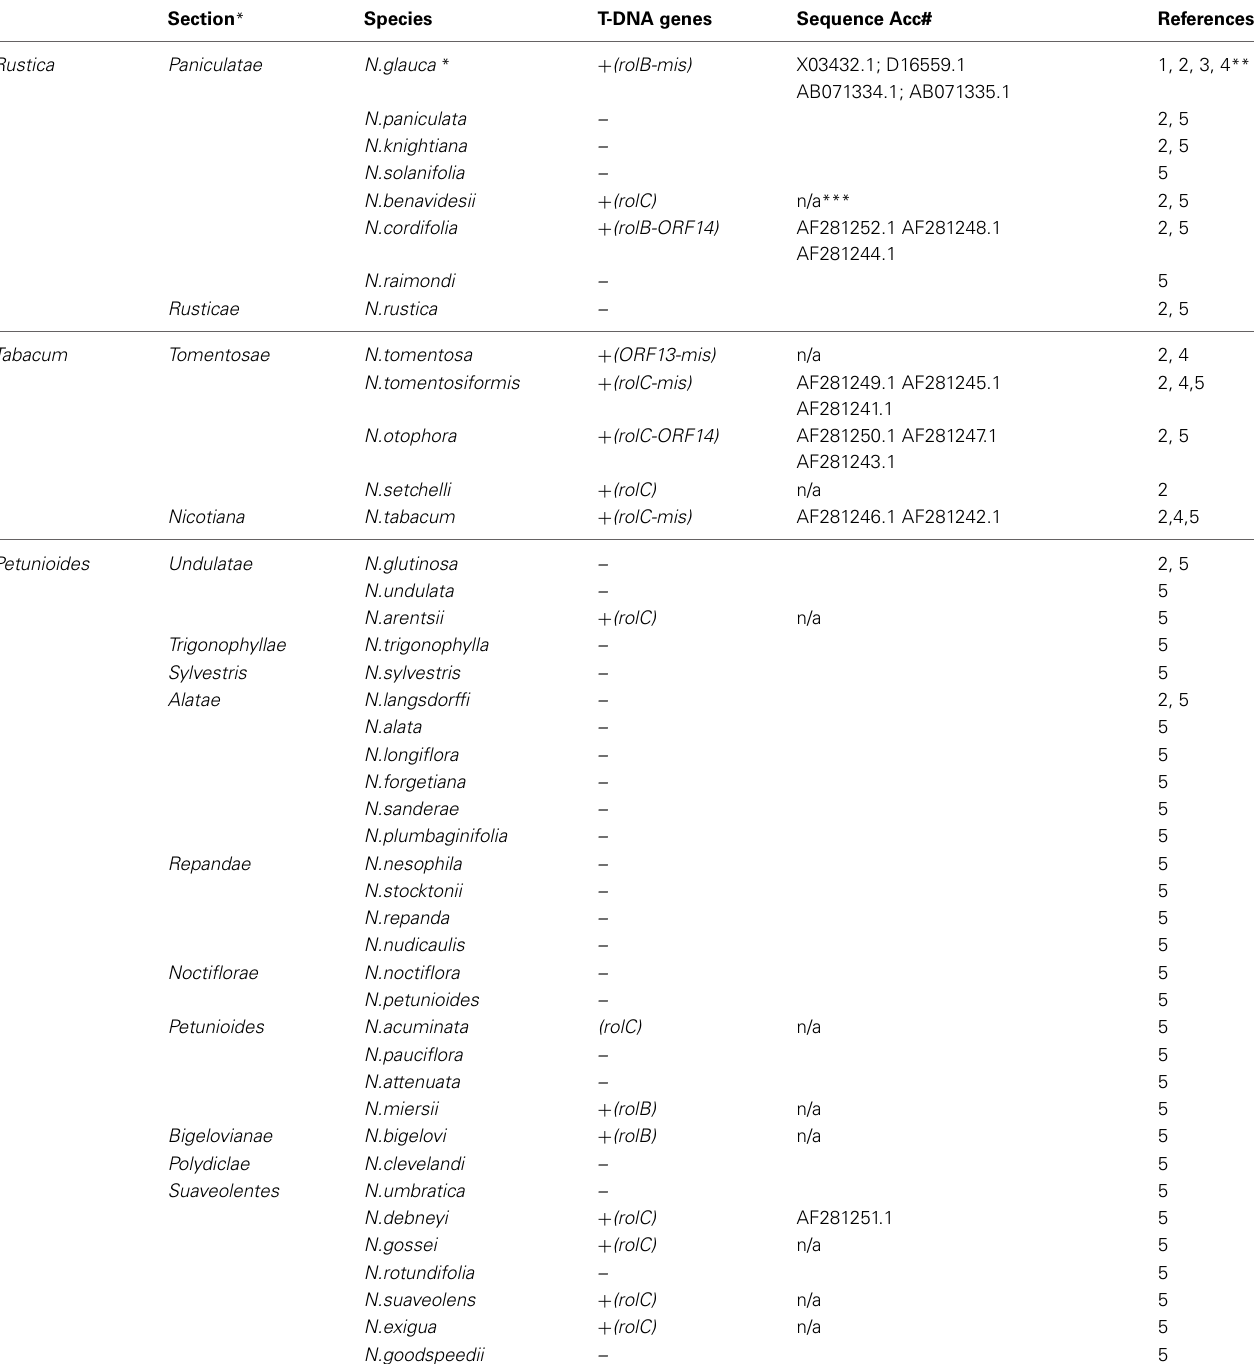
Table 1 | Distribution of T-DNA-like sequences among Nicotiana